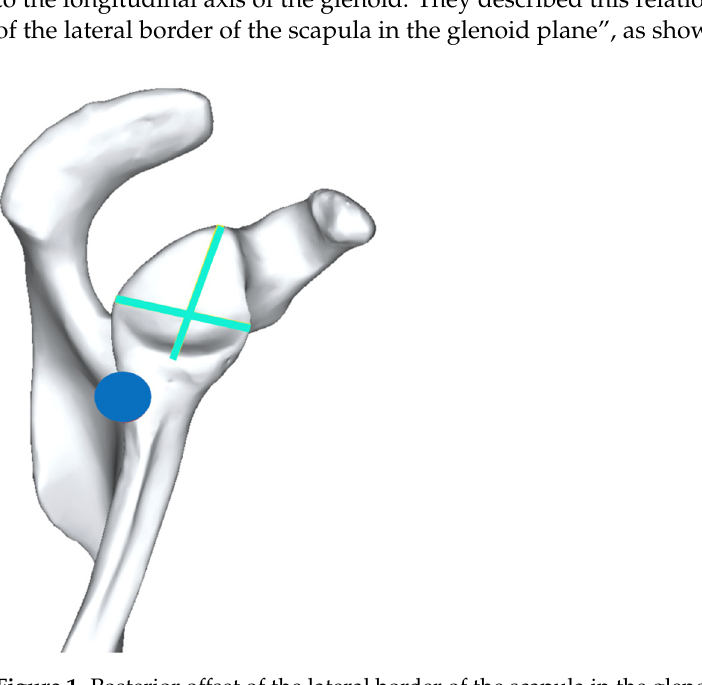
Figure 1. Posterior offset of the lateral border of the scapula in the glenoid plane.